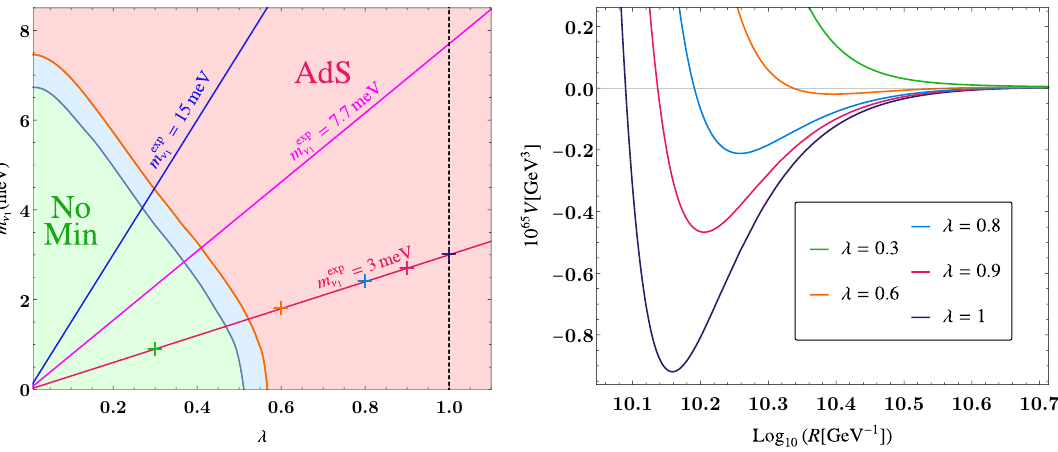
Figure 2 . Left: lightest neutrino mass versus the scanning parameter λ for Majorana neutrinos. The green area corresponds to runaway dS vacua and the pink one to AdS vacua, with a narrow region of dS vacua in between. Straight lines correspond to homogeneous scans for different physical neutrino masses. The lines necessarily cross from the AdS to the runaway area, violating the AdS distance conjecture. Right: in this figure we show how the potential changes along the scanning for the particular value m exp = 3 meV. Coloured crosses in the left hand side correspond to the ν coloured curves in the plot on the right hand